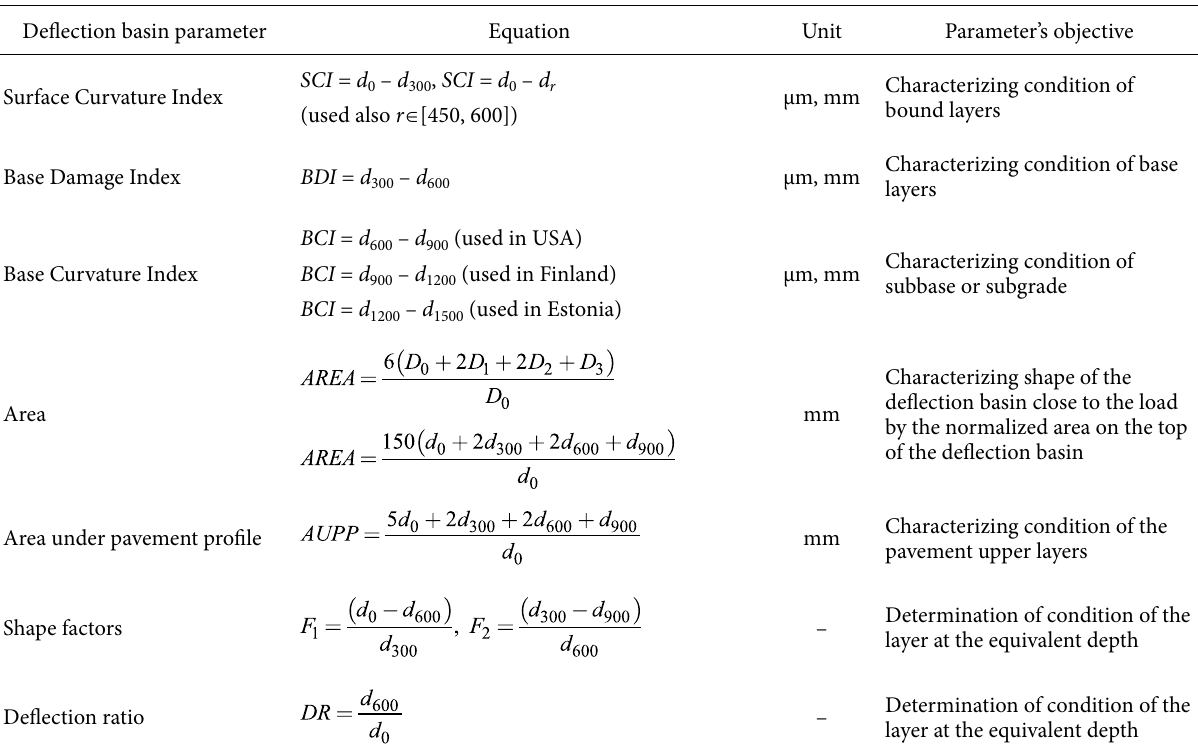
Table 1. Widely used FWD deflection basin parameters (Kim et al. 2000; Talvik 2007) Deflection basin